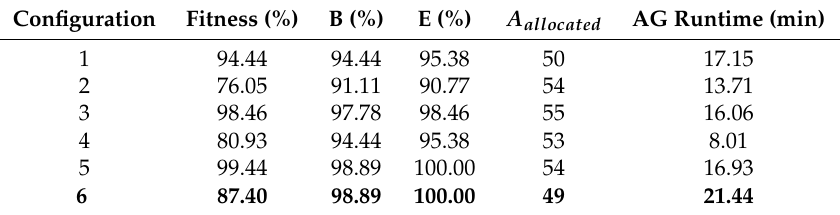
Table 4. Results obtained when simulating a 10 kA lightning discharge at bus B 35 .